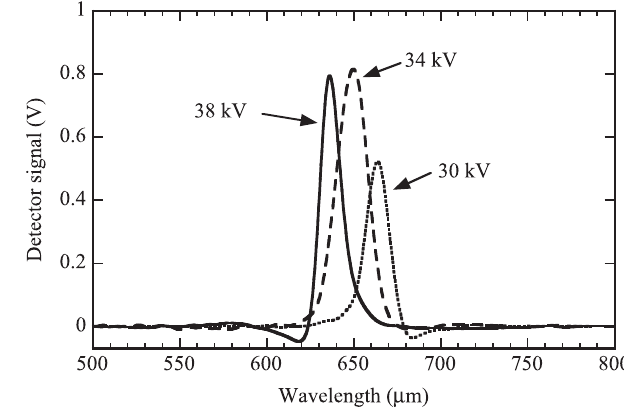
FIG. 4. Spectrum taken at 34 kV showing the Smith-Purcell band from 420 – 500 (cid:4) m , the r ¼ 1 mode at 645 (cid:4) m , and the r ¼ 0 mode at 790 (cid:4) m . These data were collected from the upstream end of the